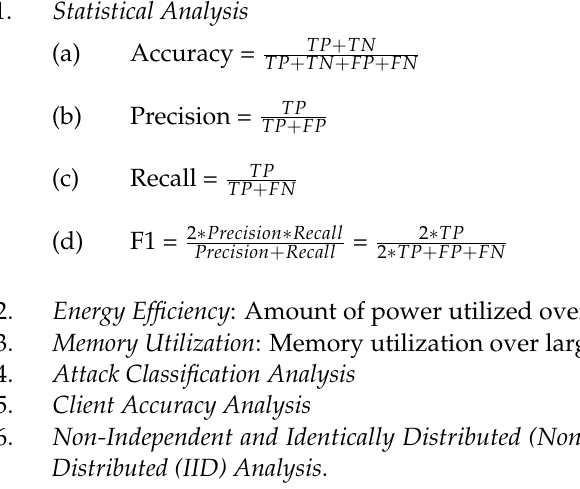
GRU-Model 1: Figure 5 shows the results for comparison for GRU-Model 1. Statistical parameters of accuracy, precision, recall, and F1-measure have been calculated. It can be seen that the proposed FL-based attack classification is more accurate by registering an enhanced measure of 95.65% in comparison to LR (94.65%), RNN (92.36%), and DNN (90.26%). For precision analysis, the proposed technique of GRU-LSTM can outperform the deep learning techniques of LR (93.78%), RNN (92.01%), and DNN (89.16%) by registering an enhanced measure of 93.65%. Similarly, the f-measure and recall measure were analyzed for the proposed model. In the current scenario, the proposed model registered enhanced values of 94.65% and 93.26% for f-measure and recall, respectively. On the other hand reduced values for LR (92.65%, 93.54%), RNN (90.12%, 89.99%), and DNN (88.21%, 87.59%) were acquired. This